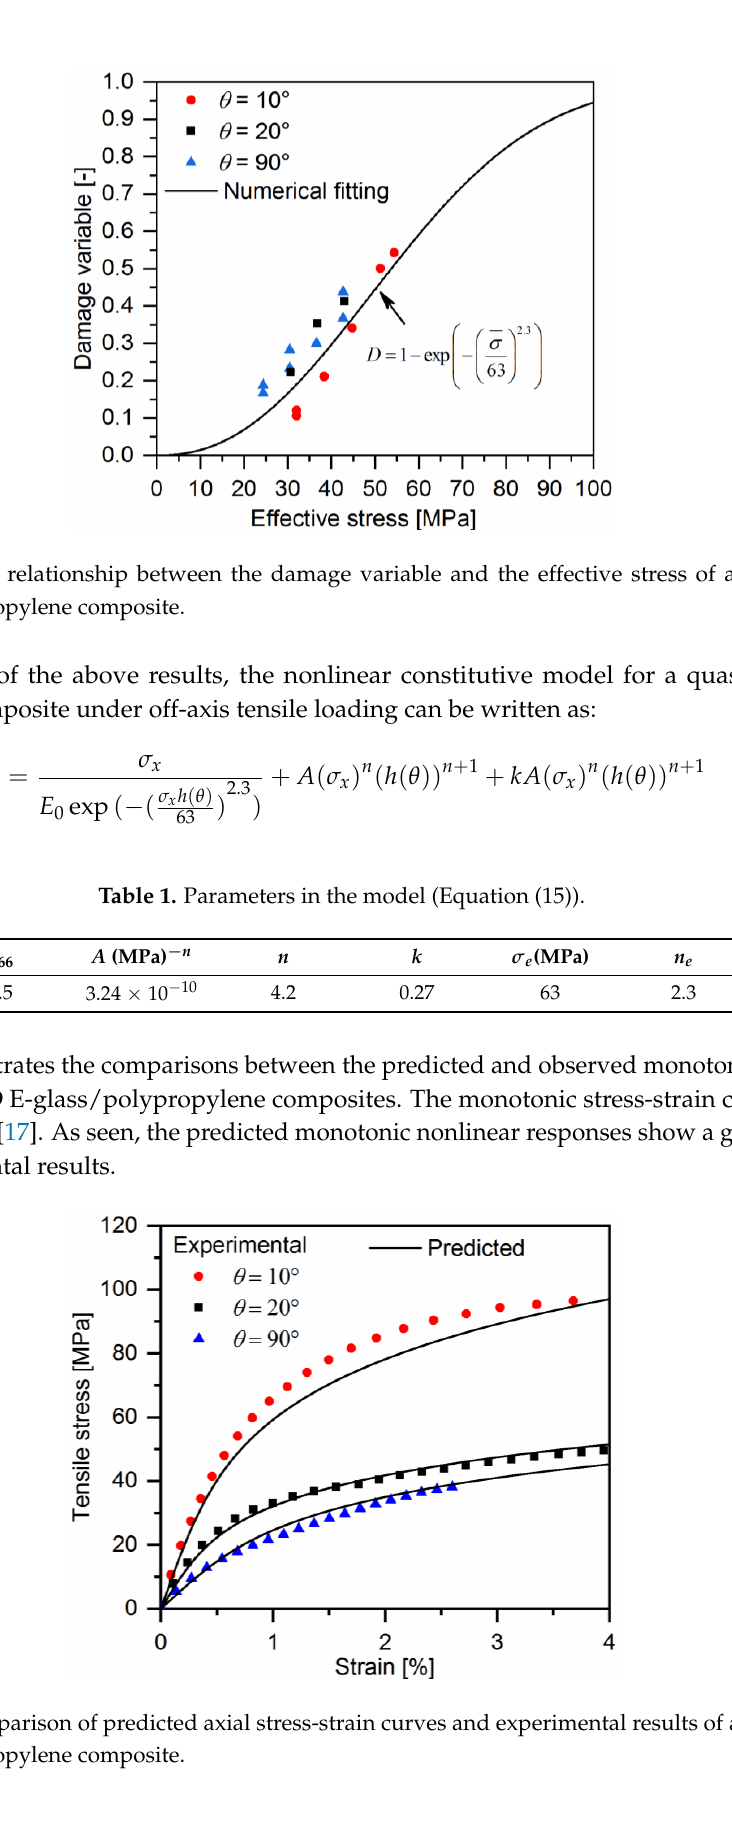
Figure 14. Comparison of predicted axial stress-strain curves and experimental results of a quasi-UD E-glass/polypropylene composite.